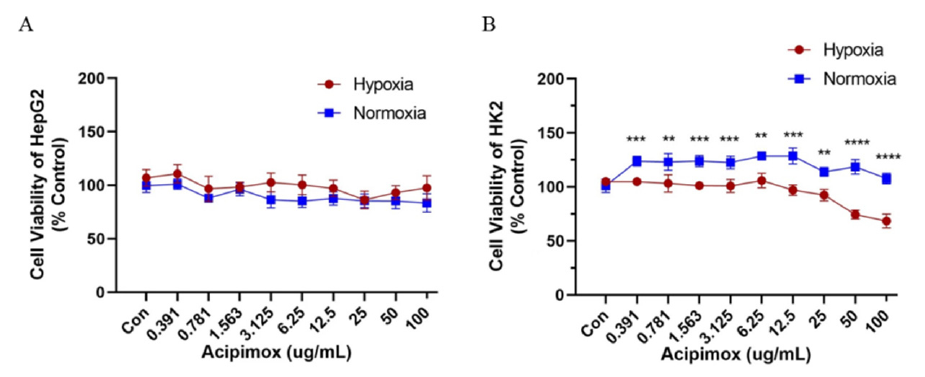
Figure 8. The cytotoxicity of acipimox on kidney and liver in normoxia and hypoxia condition. The effect of acipimox on proliferation in HepG2 ( A ) and HK-2 cells ( B ). ** p < 0.01, *** p < 0.001 and **** p < 0.0001.